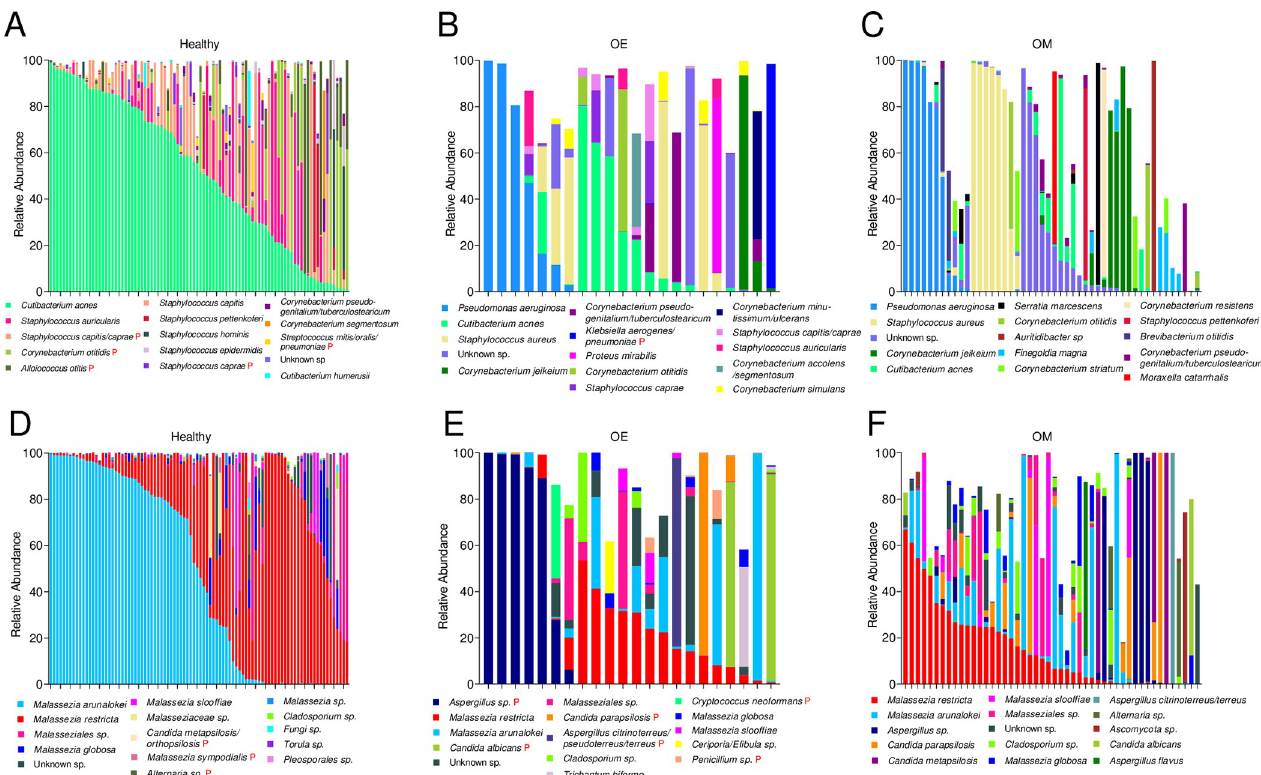
Fig 1. Microbiome profile of individual samples for bacteria (A-C) and fungi (D-F) for each group, healthy, OE (otitis externa), and OM (otitis media). Shown are the top 15 most abundant species based on relative abundance per group. A red letter (P) highlights those species known to be otitis pathogens. To ease comparison, bacterial and fungal species are consistently colored between graphs. Further information about the relative abundances of all detected species per individual can be found in S1 Table (bacteria) and S2 Table (fungi).